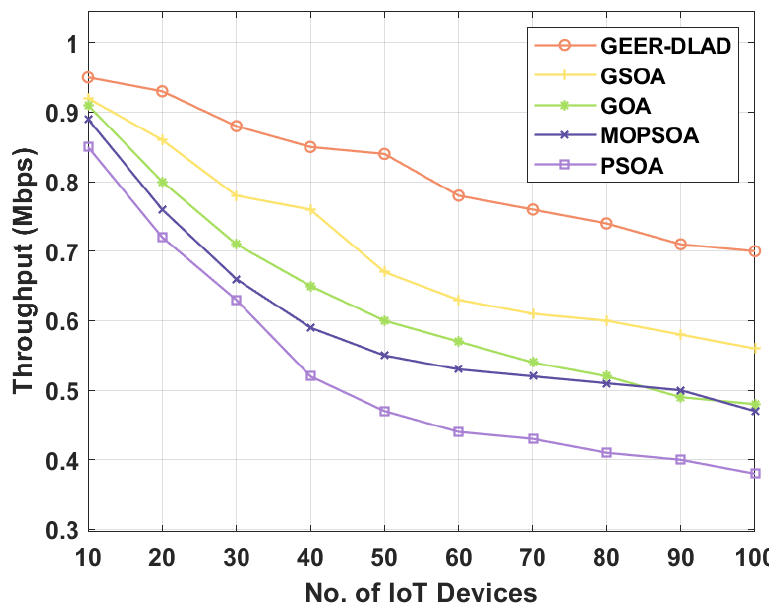
Figure 7. Throughput analysis of GEER-DLAD model.